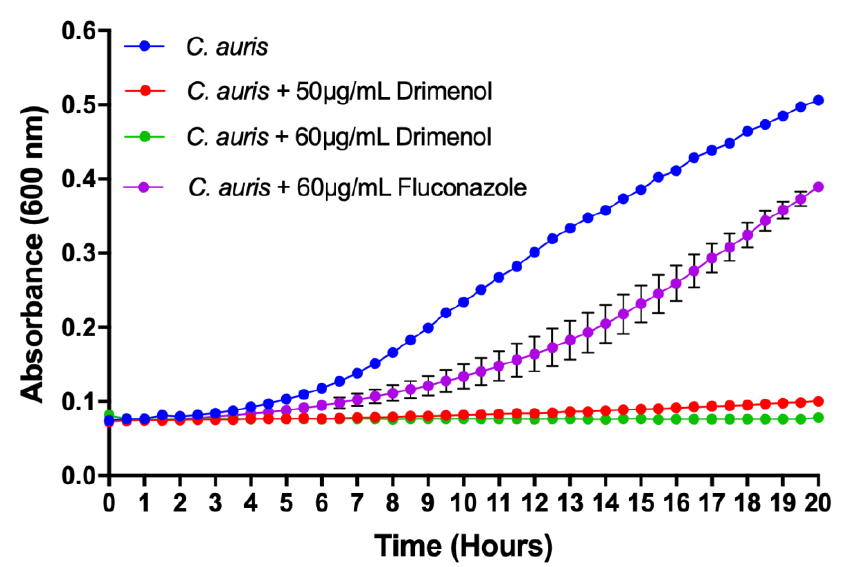
FIGURE 2: Drimenol (1) inhibits C. auris growth better than